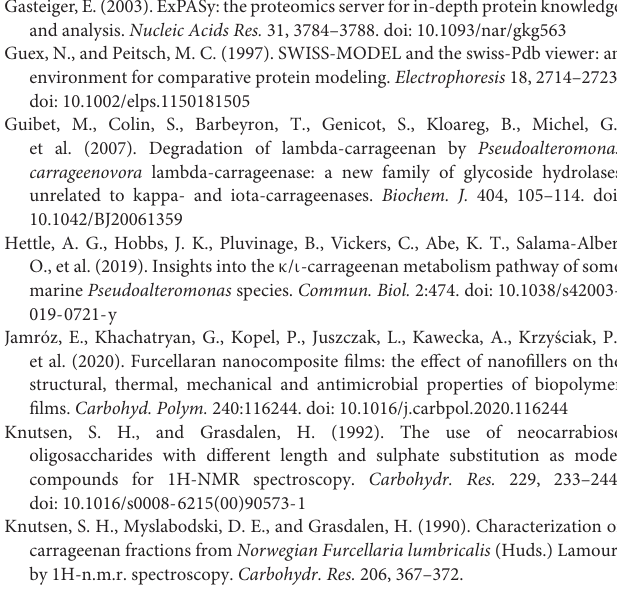
Supplementary Figure 2 | Amino acid sequence alignment of Cgbk16A_Wf with characterized GH16_13 family enzymes. Critical catalytic residues were marked by stars. Supplementary Figure 3 | The 1 H NMR (A) , COSY (B) , and TOCSY (C) spectra of the hexasaccharide (DA-G4S) 1 (DA-G) 2 . The α -Gr indicated α -G residue located at the reducing end; H1/H2 indicated the cross-peak between H-1 and H-2, etc. The assignment of 1 H chemical shifts of α -Gr and G4S were listed in Supplementary Table 2 . Supplementary Figure 4 | LC-HRMS analysis of products prepared by incubating 100 mg substrate with different enzyme dosages (1–50 U) of Cgbk16A_Wf for 24 h. (A) Disaccharide. (B) Tetrasaccharide. (C) Hexasaccharide. Supplementary Figure 5 | The superimposition of Cgbk16A_Wf (in cyan) onto PcCgkA (in tan), focusing on the scene of − 1 subsites. The ligand and the surface of PcCgkA were shown. Supplementary Table 1 | The theoretical m/z of carrageenan oligosaccharides. Supplementary Table 2 | The 1 H chemical shift (ppm) of α -Gr and G4S residues in hexasaccharide (DA-G4S) 2 (DA-G) 1 and (DA-G4S) 1 (DA-G) 2